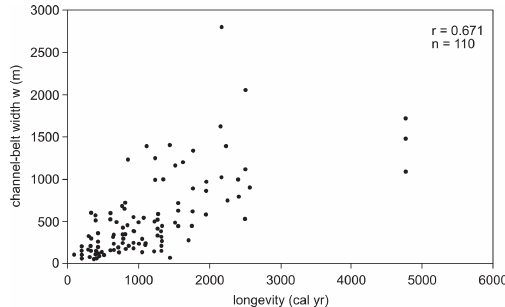
Figure 11. Relationship between channel-belt width ( w ) and du- ration of channel activity (longevity). The graph shows a fairly strong positive correlation ( r = 0 . 671), which implies that channel- belt width generally increases with longevity. Data are from 110 se- lected Rhine–Meuse channel belts with a well-established longevity (cf. Cohen et al. 2012) and width (this